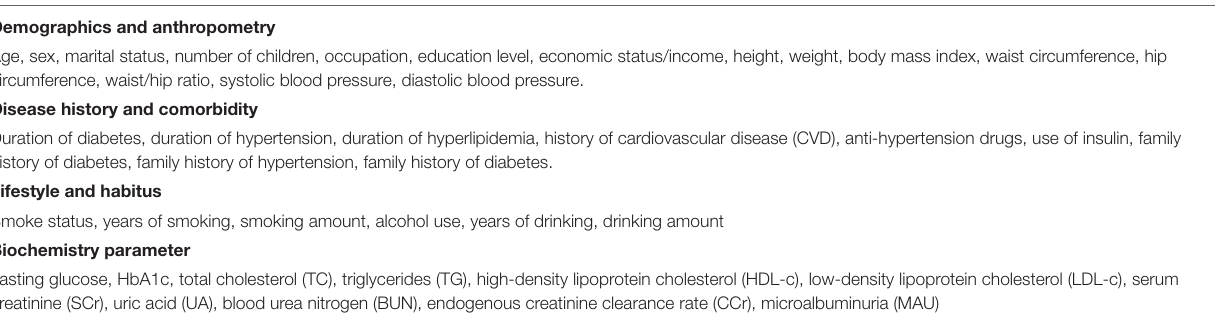
TABLE 1 | A list of the variables that were used for modeling in this study. Demographics and anthropometry